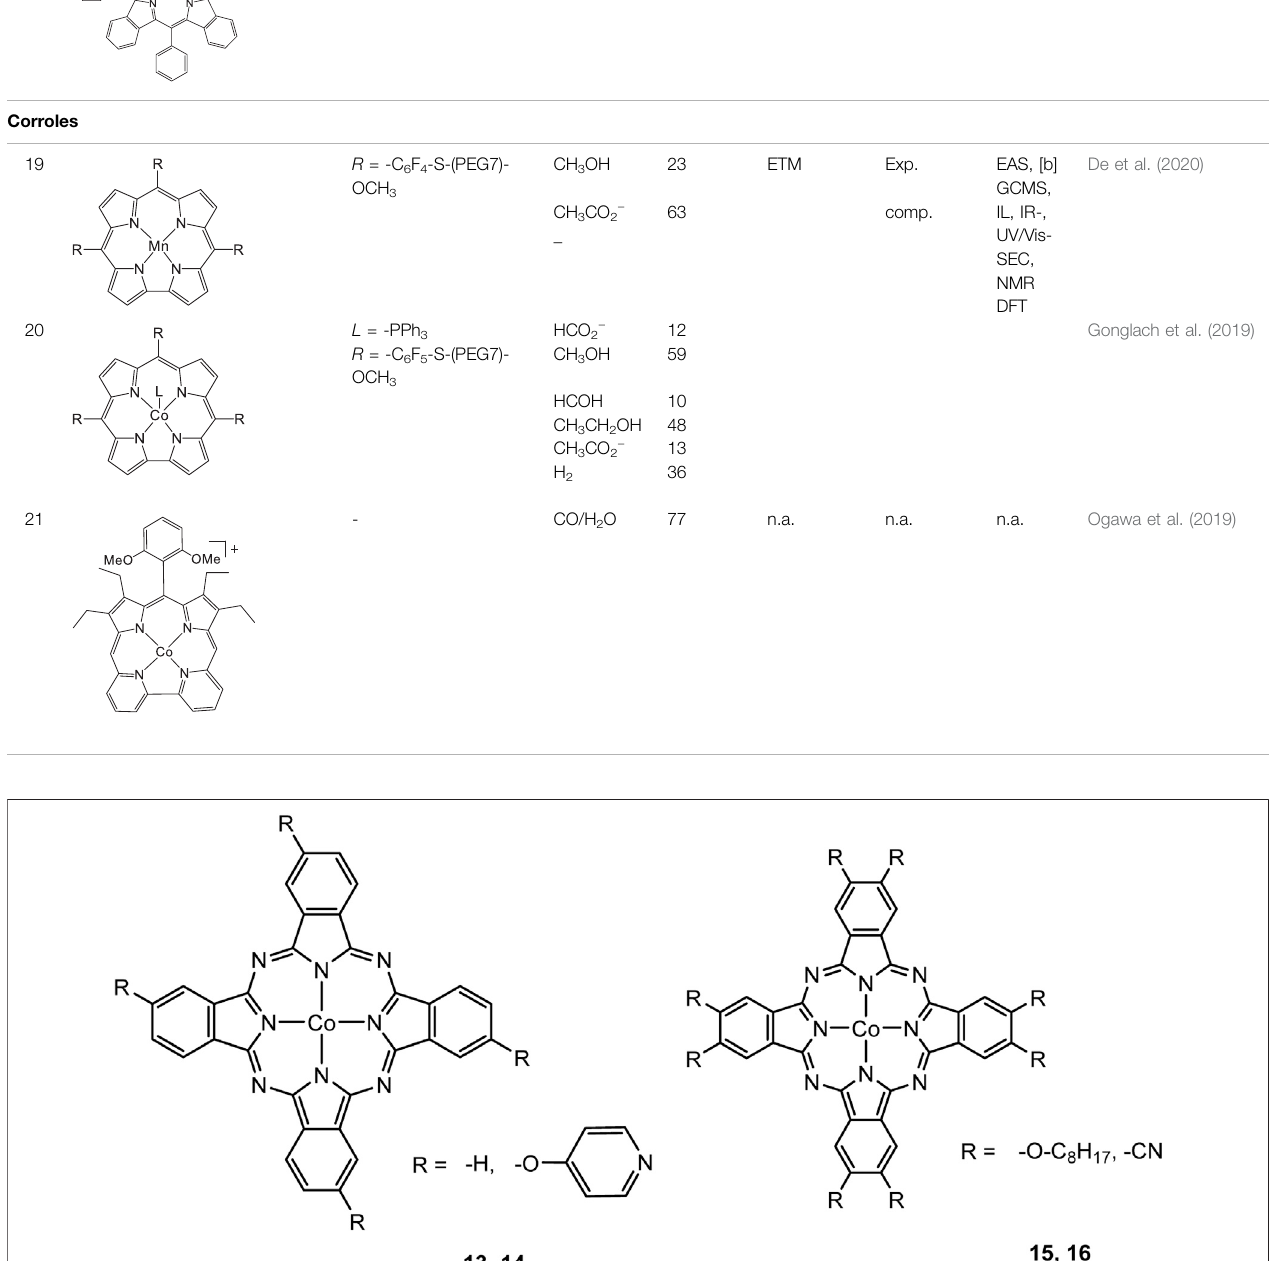
Frontiers in Chemistry |